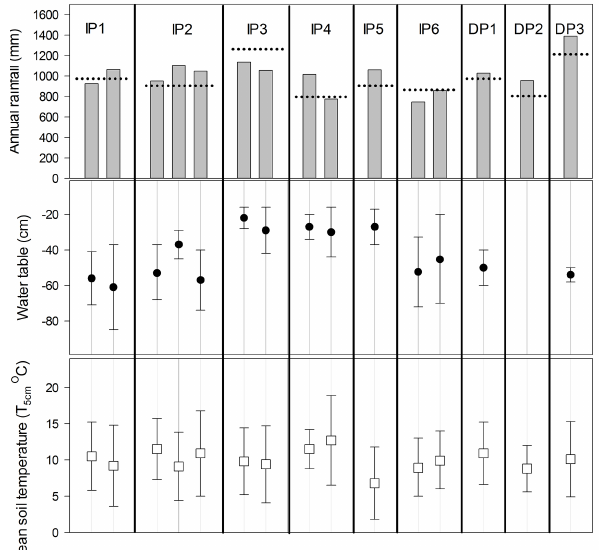
Figure 1. Annual rainfall (mm), mean annual water tables (cm), mean annual temperature ( ◦ C) at 5cm depths ( T 5cm ) at sites IP1 (2 years), IP2 (3 years), IP3 (2 years), IP4 (2 years), IP5 (2 year), IP6 (2 years), DP1 (1 year), DP2 (1 year) and DP3 (1 year). Dotted horizontal line indicates 30-year mean rainfall at each site (1981– 2010; Met Éireann, http://www.met.ie/, and Met Office UK, http: //www.metoffice.gov.uk). Error bars are standard deviations. Nega- tive water table values indicate water level below the soil